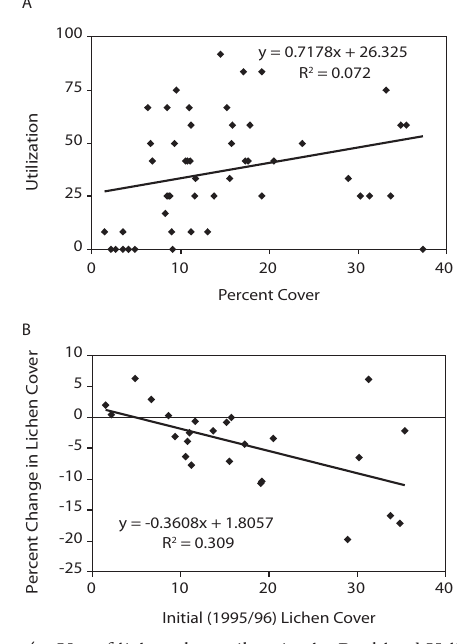
Fig. 4. Use of lichens by caribou in the Buckland Valley, Seward Peninsula, Alaska. A) Utilization versus amount of lichen cover (1995/96 and 2005 data) B) Percent change in lichen cover from 1995/96 to 2005 versus initial (1995/96) lichen cover.